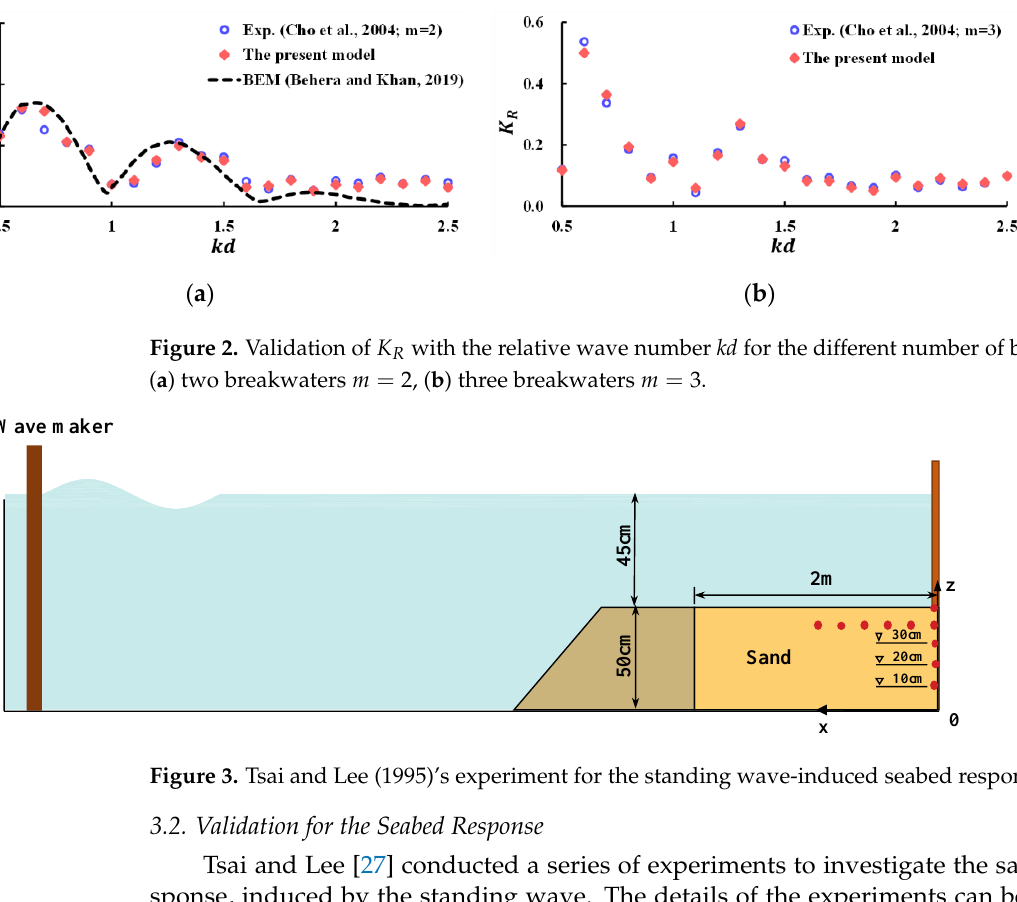
( b ) Figure 4. Time histories of the wave − induced oscillatory pore pressure at the various horizontal positions at 𝑧 = 40 cm . Symbols: red lines: numerical results, ○ : experimental data. ( a ) Pressure on the line, parallel with the seabed surface. ( b ) Pressure on the right side of the sand bed.